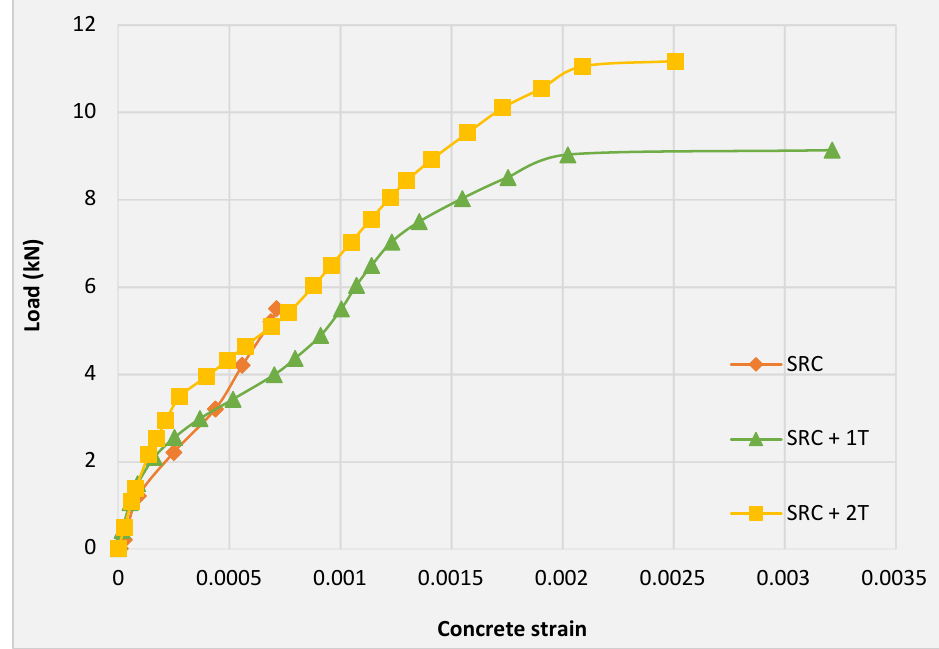
Figure 9. Compressive load versus strain curve of concrete for the three tested slab specimens.